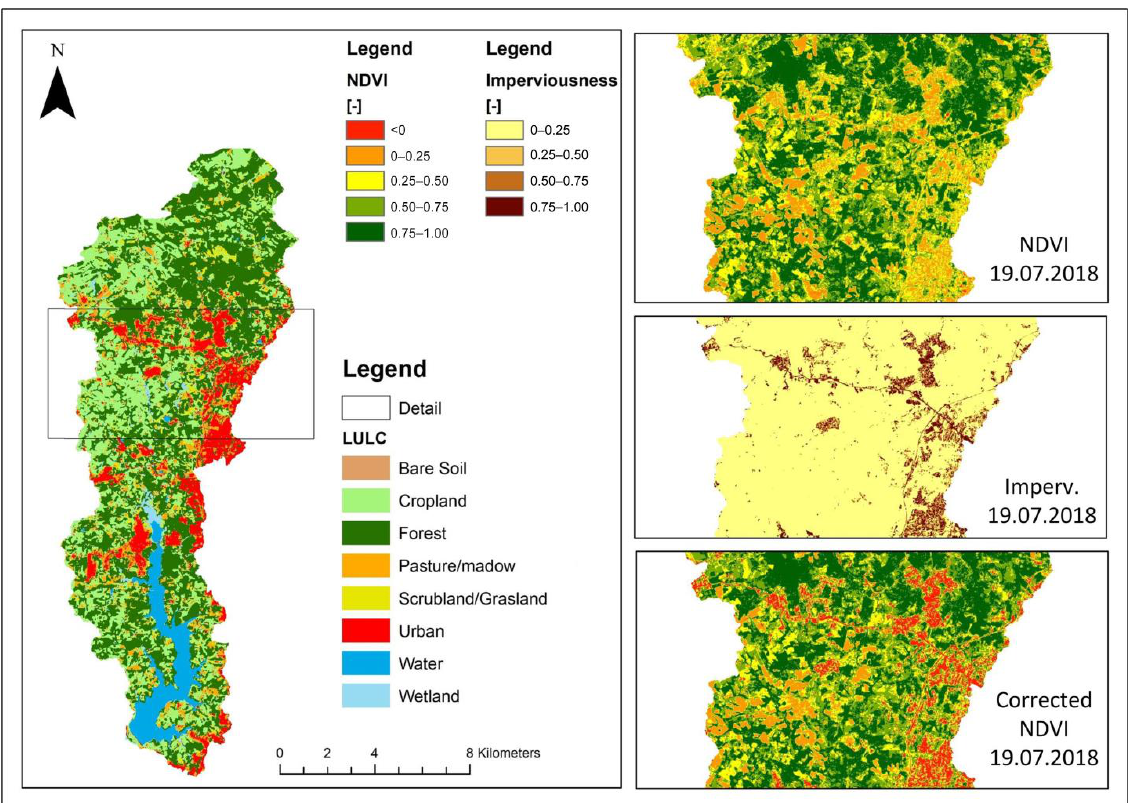
Figure 6. Correction of normalized difference vegetation index (NDVI) values for urban areas. Figure 7. Correction of normalized difference vegetation index (NDVI) values for urban